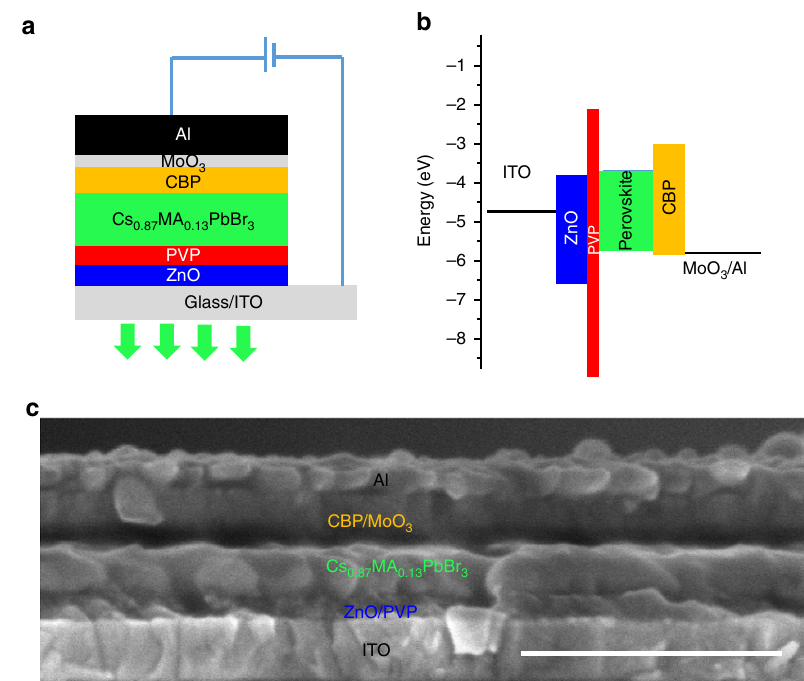
Figure 3 | Device structure of CsPbBr 3 inorganic-based perovskite LEDs. ( a ) Device structure, glass/ITO/ZnO/PVP/CsPbBr 3 /CBP/MoO 3 /Al, here PVP is polyvinyl pyrrolidine, CBP is 4,4 0 -Bis(N-carbazolyl)-1,1 0 -biphenyl. ZnO are CBP/MoO 3 are used as the electron and hole injection layers, respectively. PVP was used to improve peorvskite morphology and also passivate the interface defects and improve charge injection balance. ( b ) Band alignment of each functional layer. ( c ) Cross-sectional SEM image of the LEDs, scale bar is